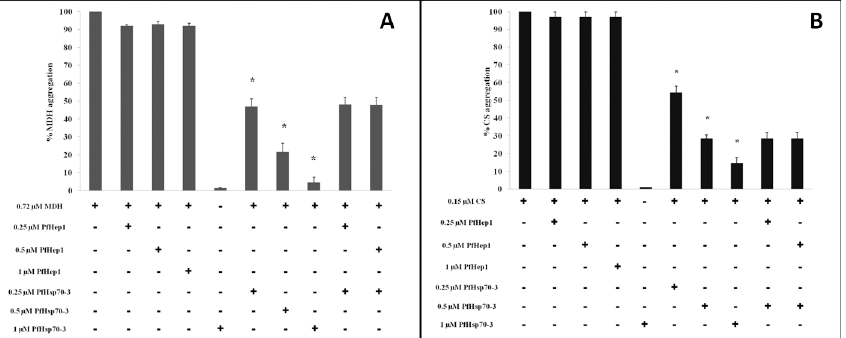
Fig 5. PfHep1 did not prevent the aggregation of MDH or citrate synthase. ( A ) MDH aggregation suppression assays were initiated by the addition of 0.72 μ M MDH to assay buffer at 45°C for 30 min and monitored by light scattering at 360 nm. Varying concentrations of PfHep1 resulted in less than 10% suppression of MDH aggregation. ( B ) 0.15 μ M of citrate synthase was incubated at 45°C for 30 mins in both the absence and presence of varying concentrations of PfHep1 and PfHsp70-3. PfHep1 resulted in less than 3% suppression of CS aggregation. PfHsp70-3 suppressed the aggregation of both MDH and CS in a dose- dependent manner. PfHep1 did not enhance the ability of PfHsp70-3 to suppress MDH or CS aggregation and did not display intrinsic co-chaperone activity. The combined data of three independent experiments conducted in triplicate on three independent batches of protein are shown for both MDH and CS. The bars represent standard deviations. A statistically significant difference between a reaction and MDH alone is indicated by * (p > 0.05) above the reaction using a Student ’ s t-test. The addition of PfHep1 to PfHsp70-3 and substrate did not produce a statistically different decrease in aggregation compared to PfHsp70-3 and